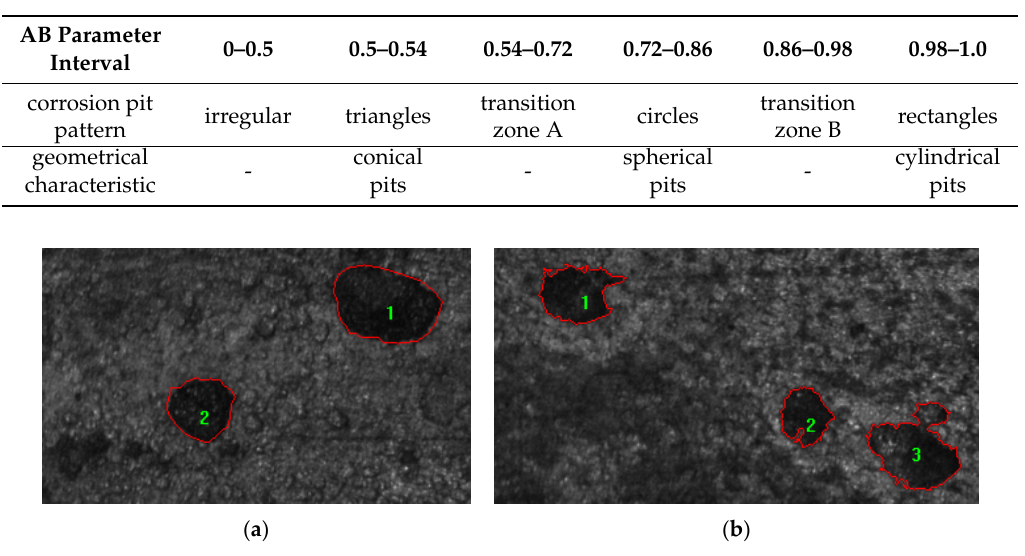
Figure 3. Typical pit patterns for different AB parameter: ( a ) Circular pits, AB parameter for the two pits is 0.73; ( b ) Transition zone A pits, AB parameters are 0.63, 0.65 and 0.59 for the three pits, respectively.